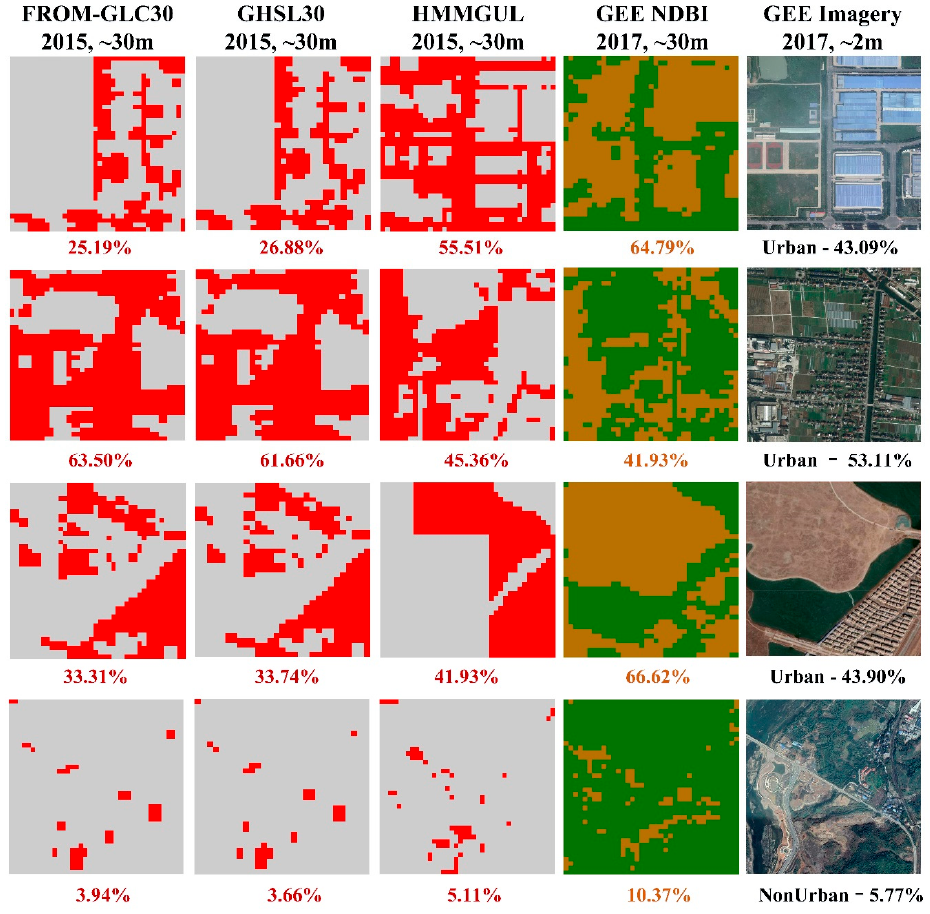
Figure 4. Four samples (0.01*0.01 degrees) of urban areas from 2015 FROM-GLC30, 2015 GHSL30, 2015 HMMGUL, the 2017 Landsat Normalized Difference Built-Up Index (NDBI), and high-resolution imagery from 2017 from the Google Earth Engine (GEE) platform. The number in the four columns on the left shows the proportion of urban pixels. The text in the last column describes the average proportion and the final label.